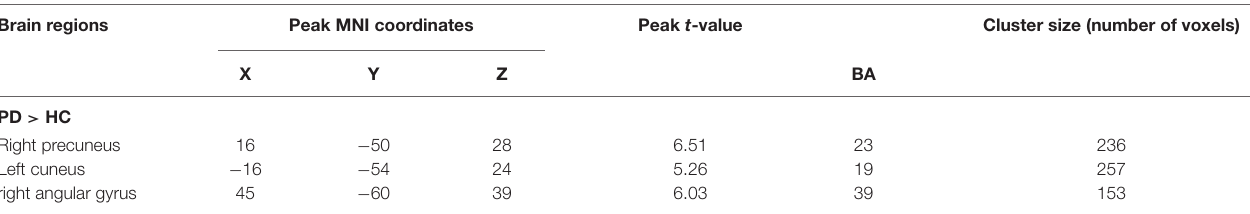
Right precuneus Left cuneus right angular